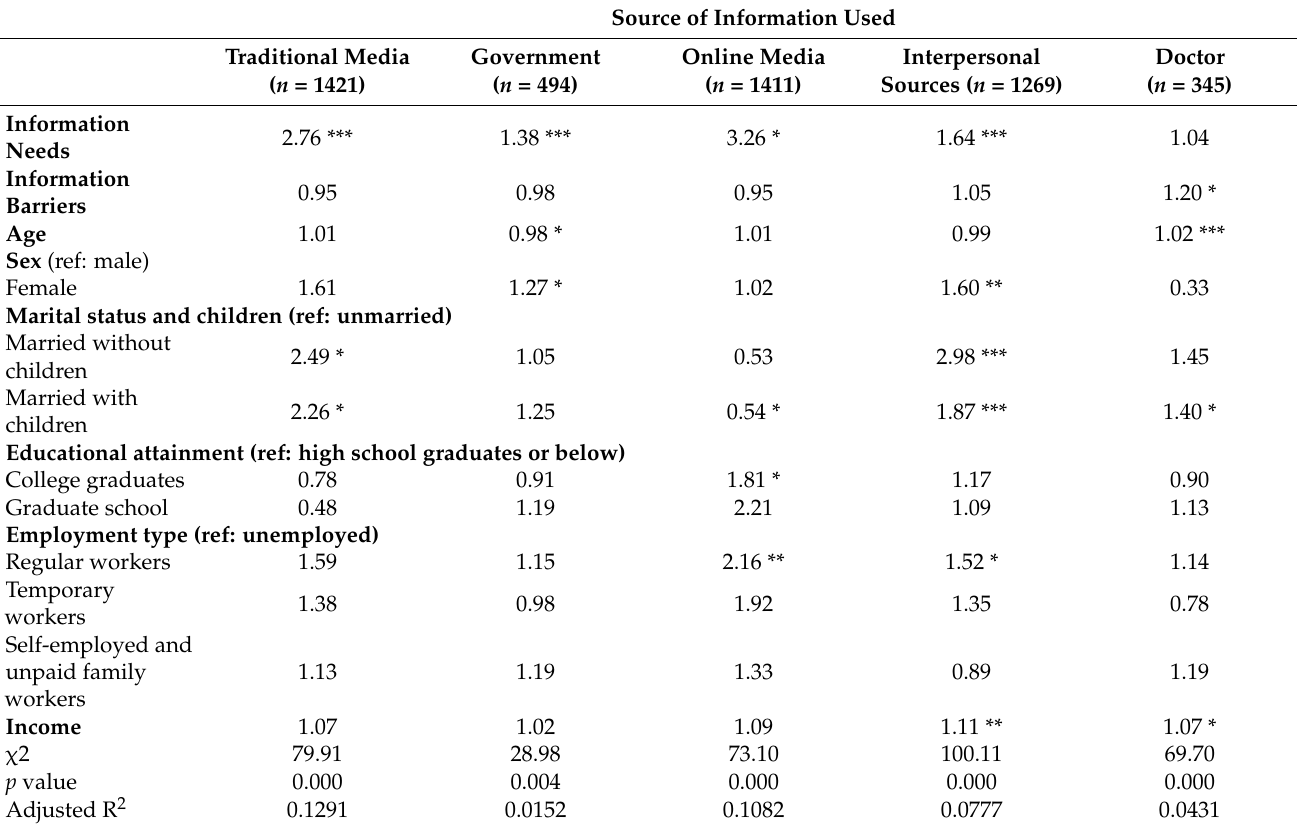
Table 4. Adjusted odds ratios of factors associated with COVID-19 information